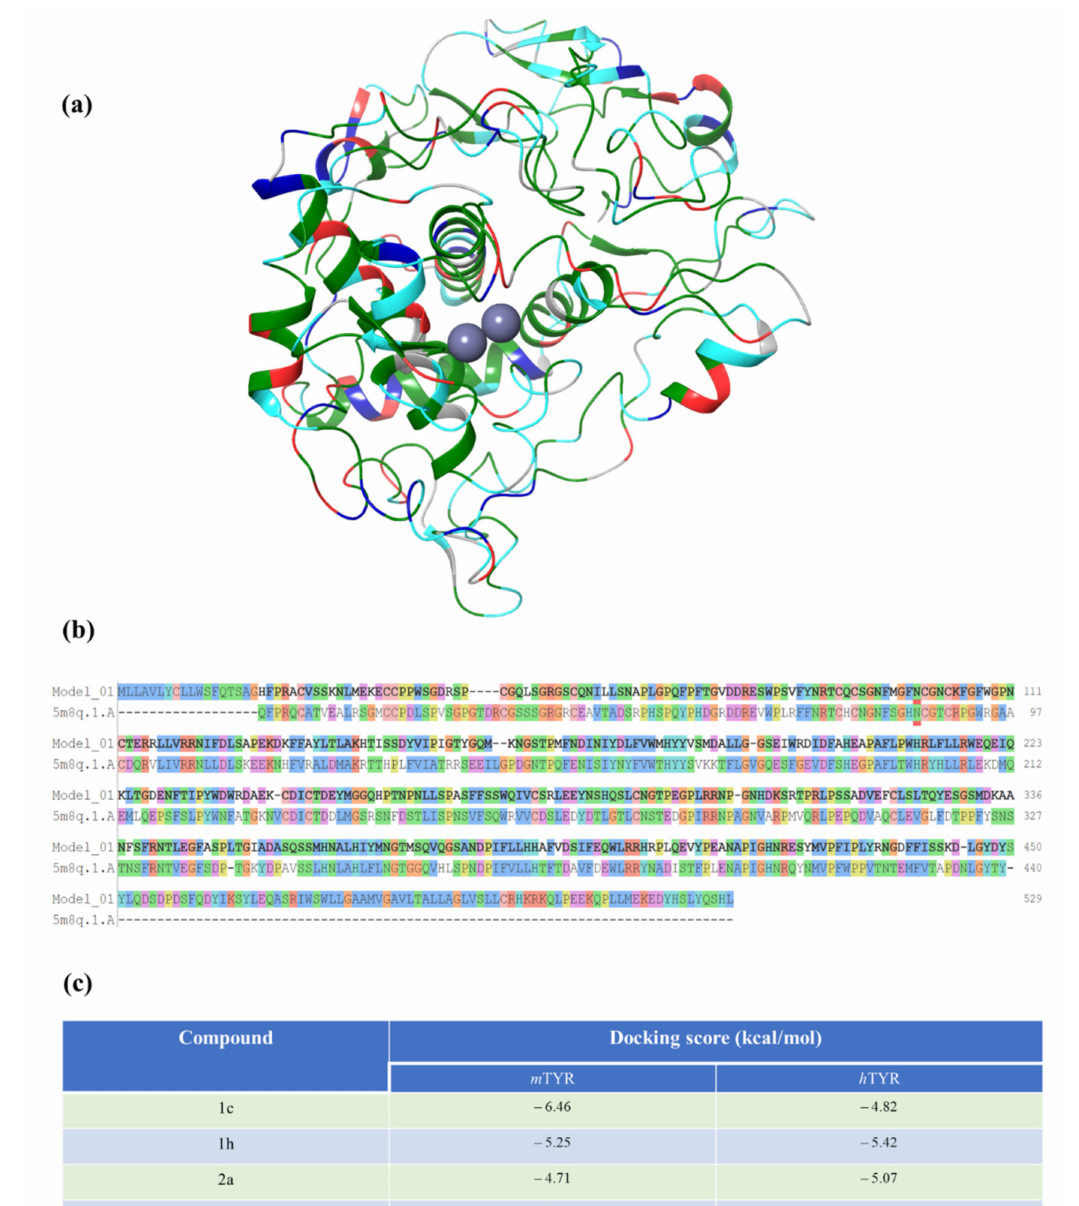
Figure 7. Human tyrosinase homology model and its genome sequences. ( a ) Superimposed protein structures and ( b ) aligned protein sequences of human tyrosinase homology model and a human TYRP1 protein template (5M8Q). The zinc ions are represented by spheres. ( c ) Docking scores of compounds 1c, 1h, and 2a, and kojic